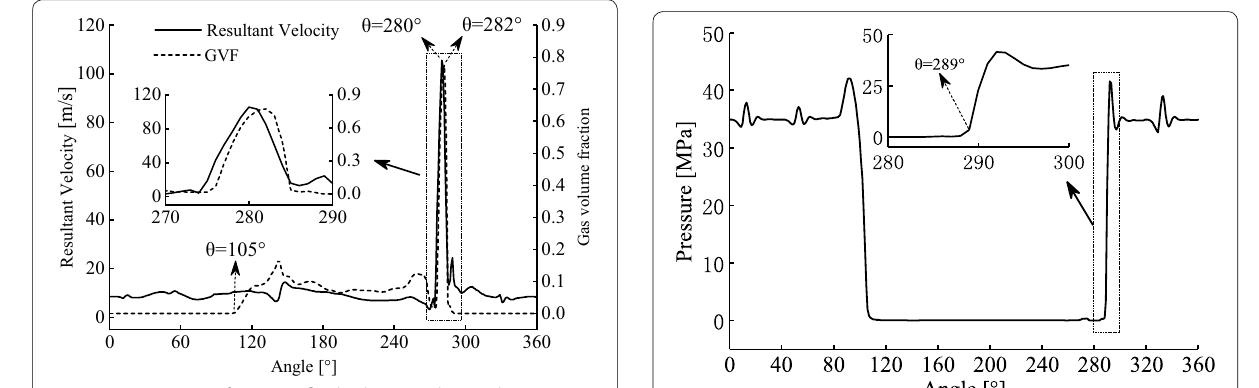
Figure 10 Variation of point P 2 fluid velocity and gas volume fraction